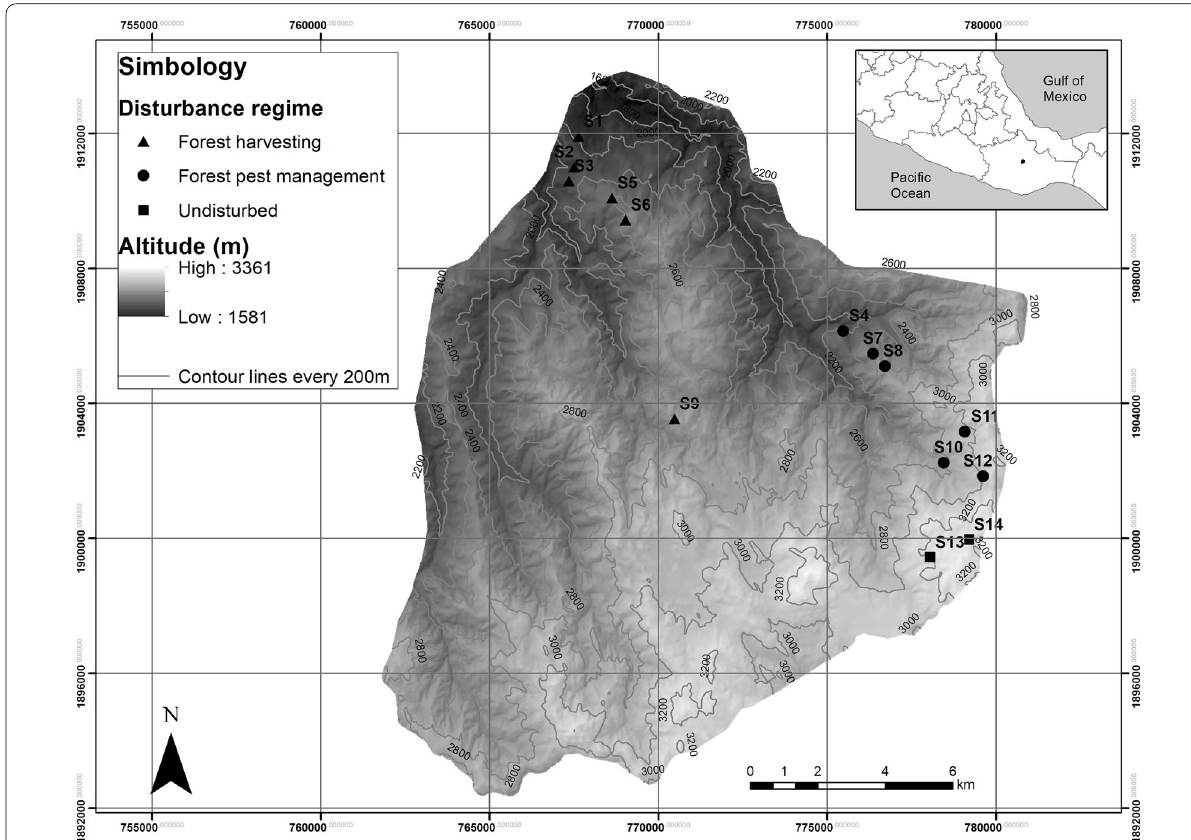
Fig. 1 Study area located in the Sierra Norte in the state of Oaxaca,